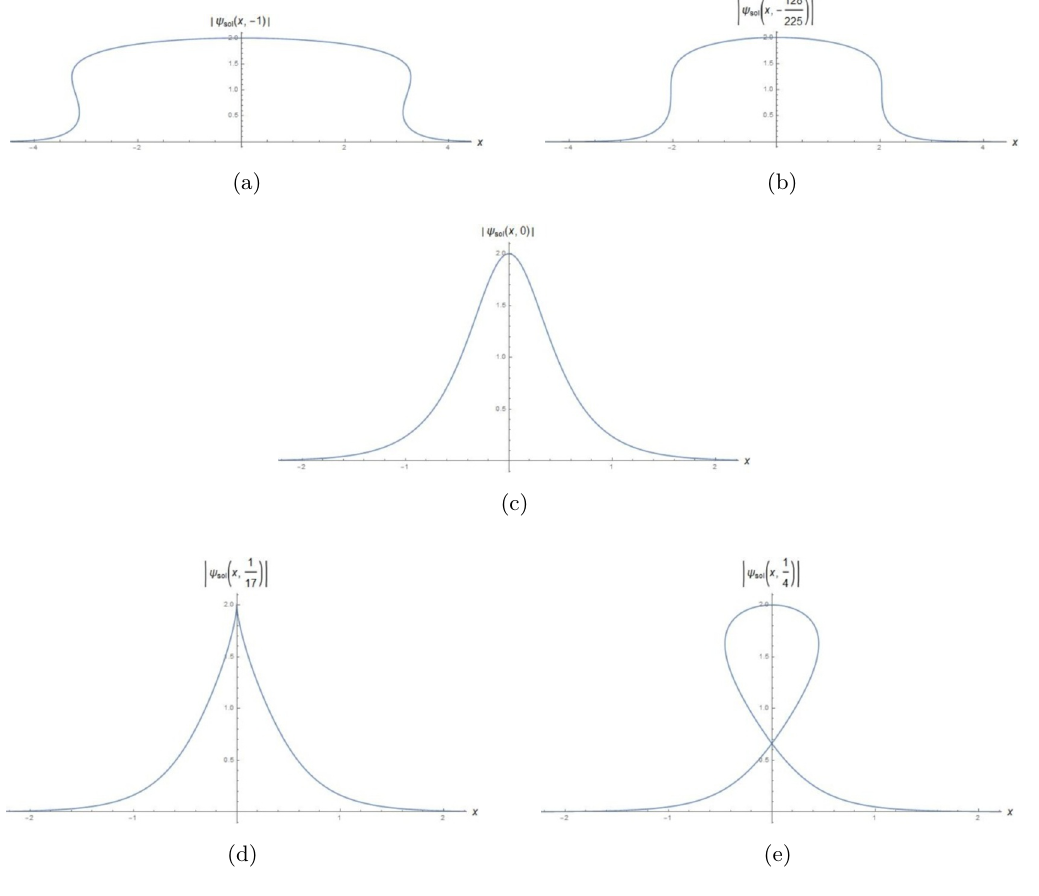
√ 2 , η = 2 , m = 1 and k = 1 . = 1 / 17 and τ − = − 128 / 225 , according crit crit